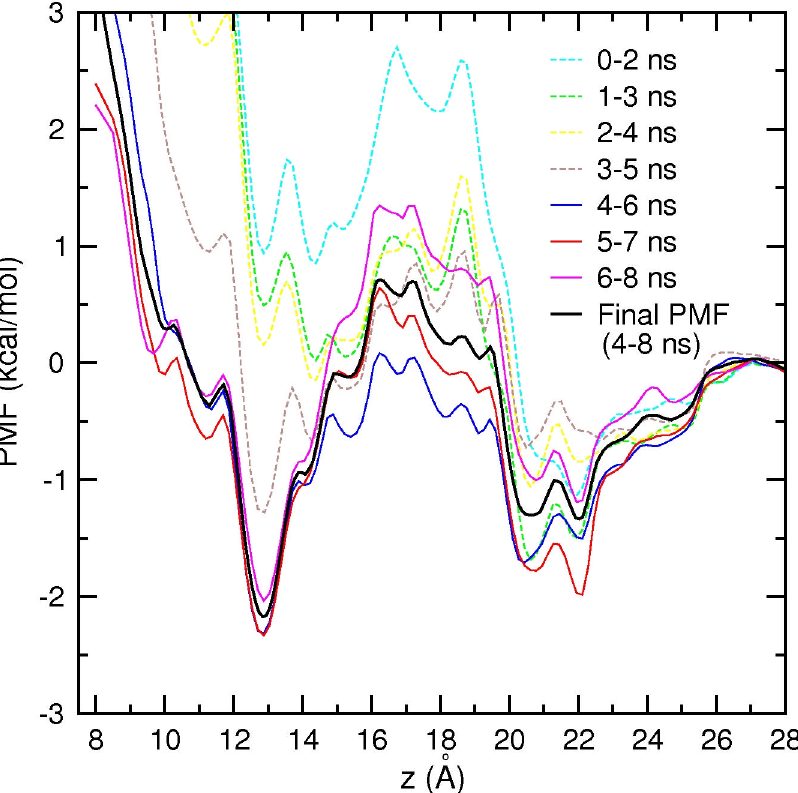
Fig 9. PMF of a Na + ion in the Na V 1.4 channel with a Na + ion resident in the SF. Block data analysis using 2 ns blocks indicates that the PMF converges after 4 ns of equilibration. Therefore the final PMF is obtained from 4 – 8 ns of the